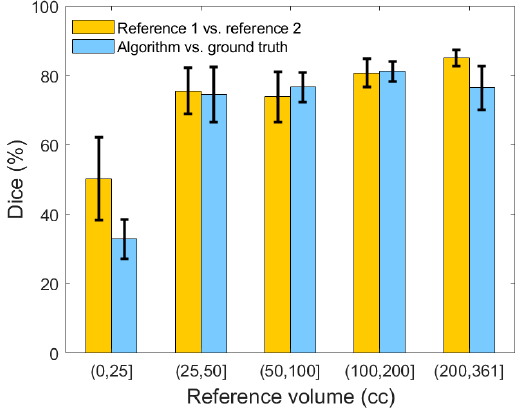
Figure 11. Comparison of the Dice similarity coefficient between reference 1, reference 2, and the result of our segmentation algorithm. Error bars represent ±1 standard errors, the 68% confidence interval.